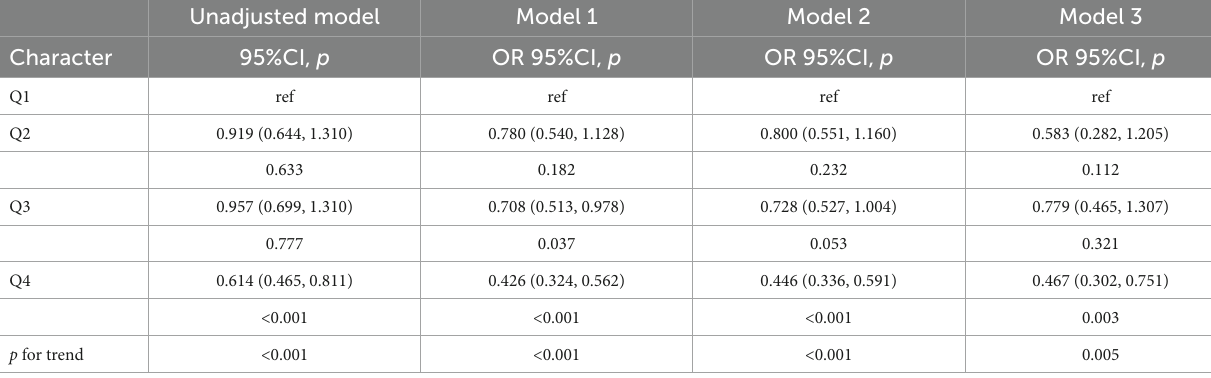
TABLE 3 Associations between total anthocyanidins and heart